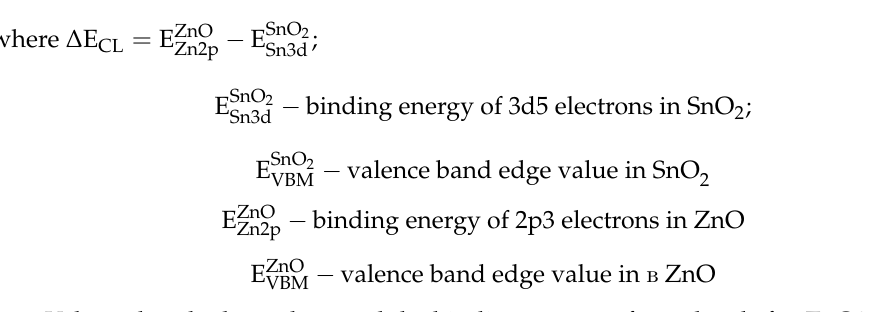
Table 3. Valence band edge values and binding energy of core levels.